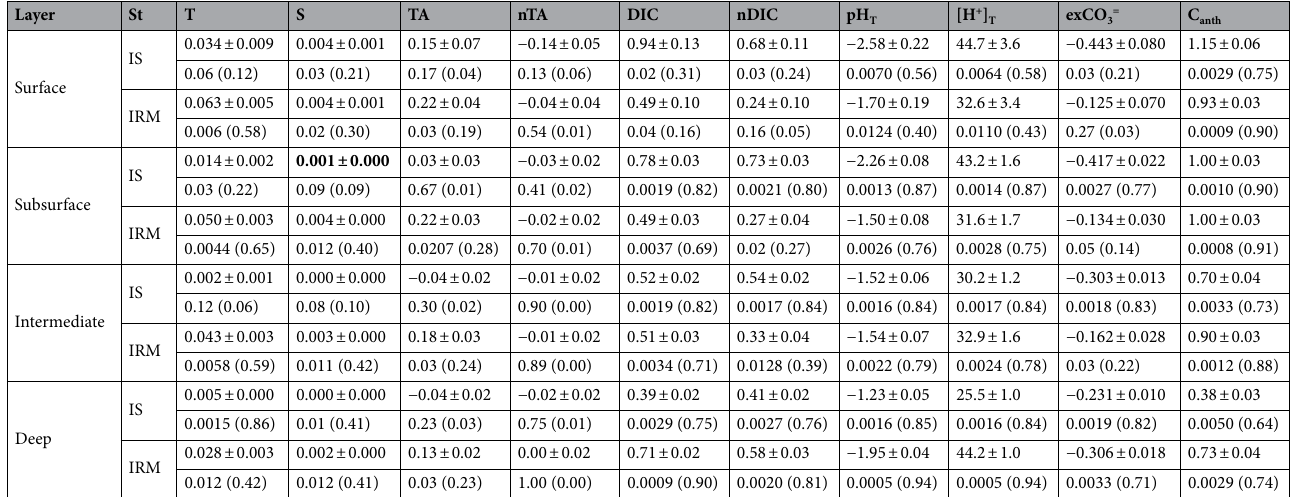
Table 2. Average trends obtained with the seasonally detrended data the in situ temperature (T in °C yr −1 ), salinity (S in yr −1 ), Total Alkalinity (TA in µmol kg −1 yr −1 ), salinity-normalized alkalinity (nTA in µmol kg −1 yr −1 ), total dissolved inorganic carbon (DIC in µmol kg −1 yr −1 ), salinity-normalized dissolved inorganic carbon (nDIC in µmol kg −1 yr −1 ), in situ pH in total scale (pH T yr −1 ), total hydrogen ion concentrations ([H + ] T in picomol kg −1 yr −1 ), ion carbonate concentration excess over aragonite saturation (exCO 3 = in µmol kg −1 yr −1 ), and anthropogenic CO 2 . The errors of the trends are included. Intercalated rows show p-level and R 2 in